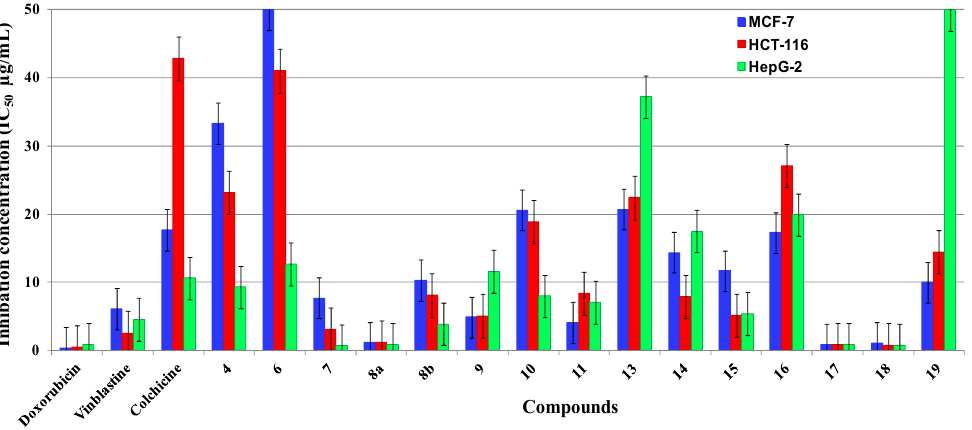
Figure 3. IC 50 values expressed in ( µ g/mL) of 3-amino-1 H -benzo[ f ]chromene derivatives 4a – h and 6a – h against MCF-7, HCT and HepG-2 tumor cells.